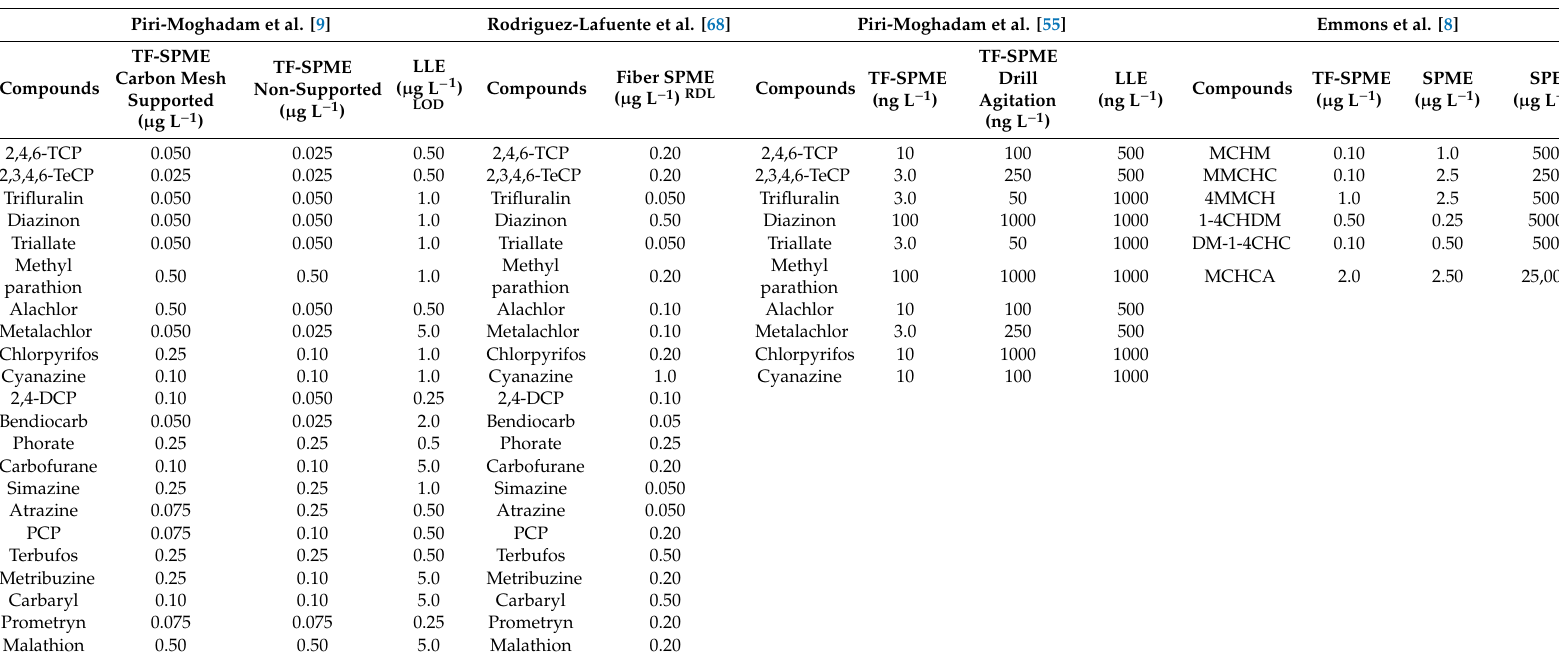
Table 2. Comparative studies demonstrating the e ffi cacy of TF-SPME over similar extraction methods. Data are in limits of quantitation (LOQs) if not otherwise noted. Piri-Moghadam et al. [9] Emmons et al. [8] Compounds